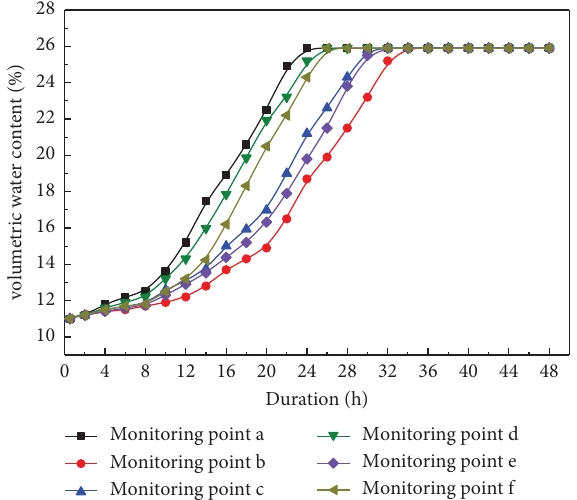
Figure 7: Variation law of the volumetric moisture content at monitoring points with duration. Figure 8: Variation law of the slope pore-water pressure with